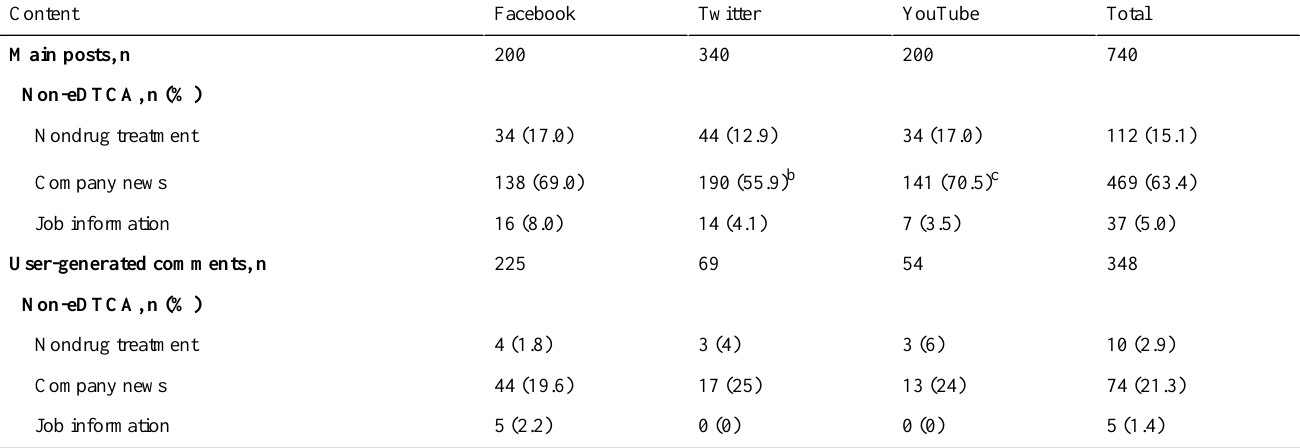
Table 3. Non–electronic direct-to-consumer advertising (eDTCA) content on company-run social media pages. a